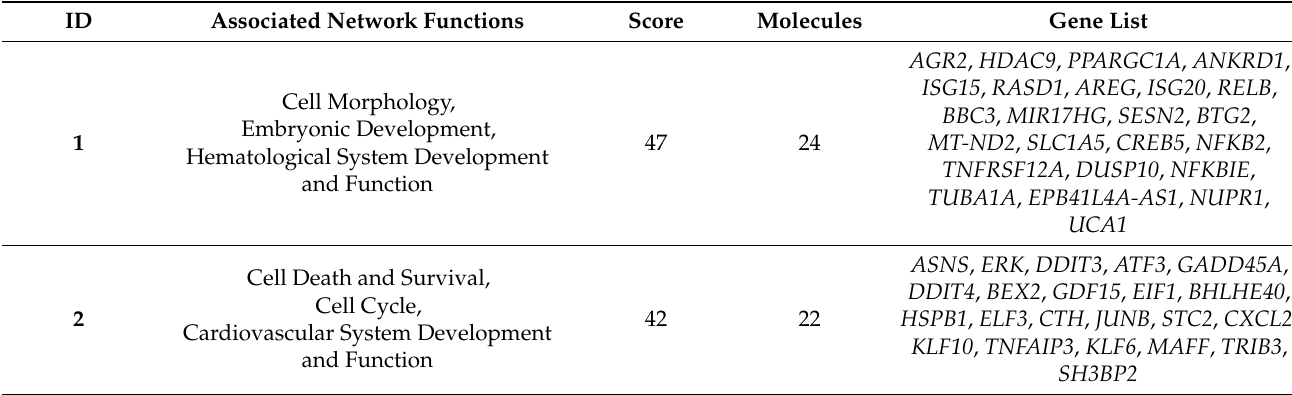
Table 1. Short-term high viral load (S-HVL)-associated network functions.